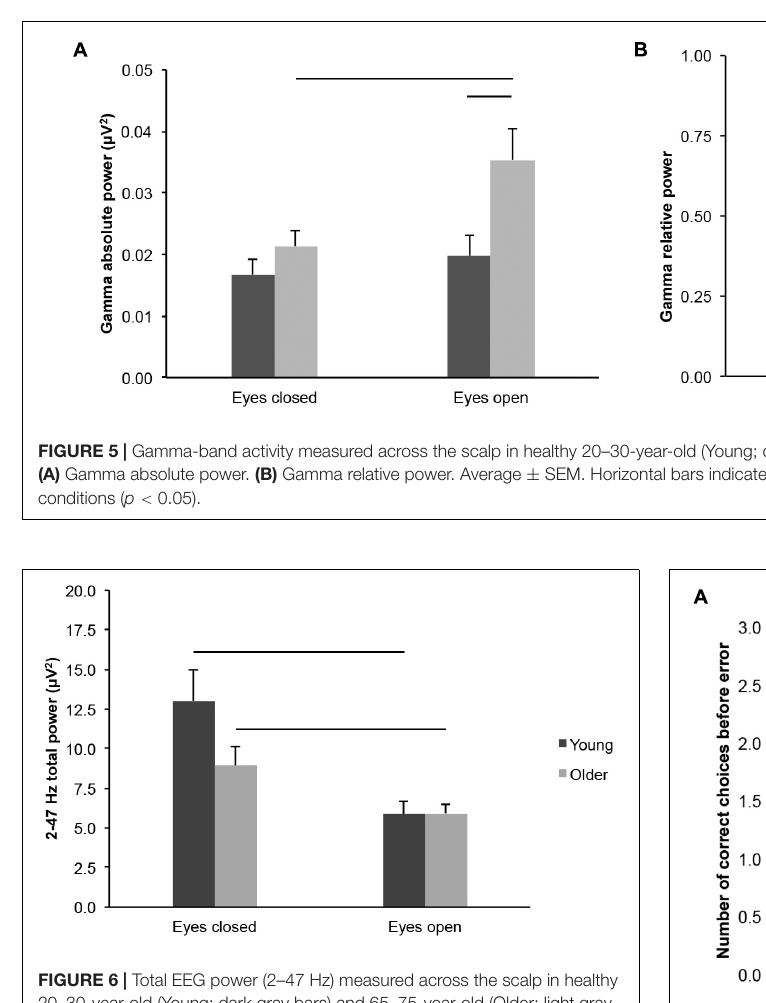
FIGURE 7 | Allocentric spatial working memory performance of healthy 20–30-year-old (Young; dark gray bars) and 65–75-year-old (Older; light gray bars) adults. (A) Number of correct choices before erring (CBE). (B) Number of errorless trials (NET). Average ± SEM. Horizontal bars indicate statistically significant differences between age groups ( p <